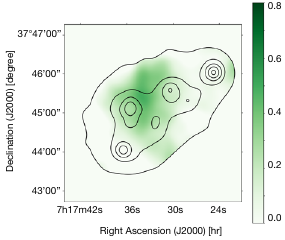
Figure 3. Left: marginalized distributions of the density probability for the lensing and HSE mass at R 500 . Cen- ter: hydrostatic-to-lensing mass ratio for each cluster at R 500 . Right: hydrostatic-to-lensing mass ratio for each cluster at a fixed R HSE . 1000